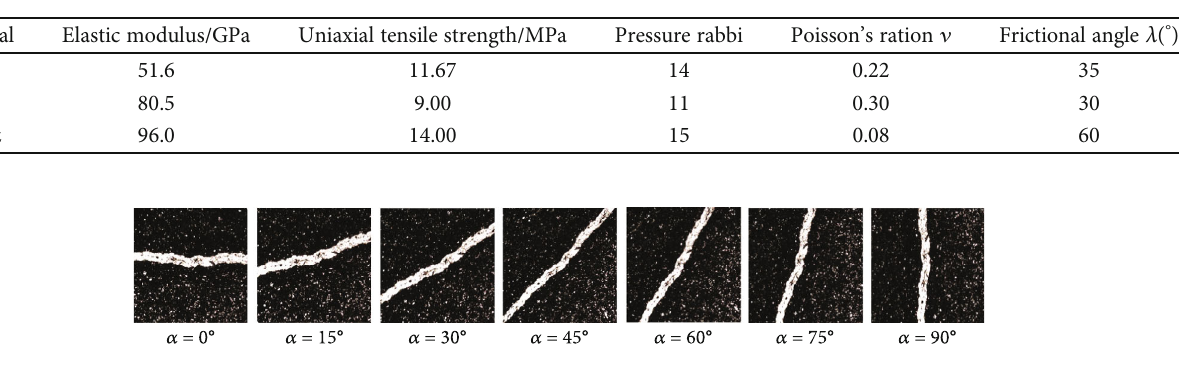
Figure 8: Numerical model and grid after shale transformation. Table 1: Material parameters of shale micromedia [39].